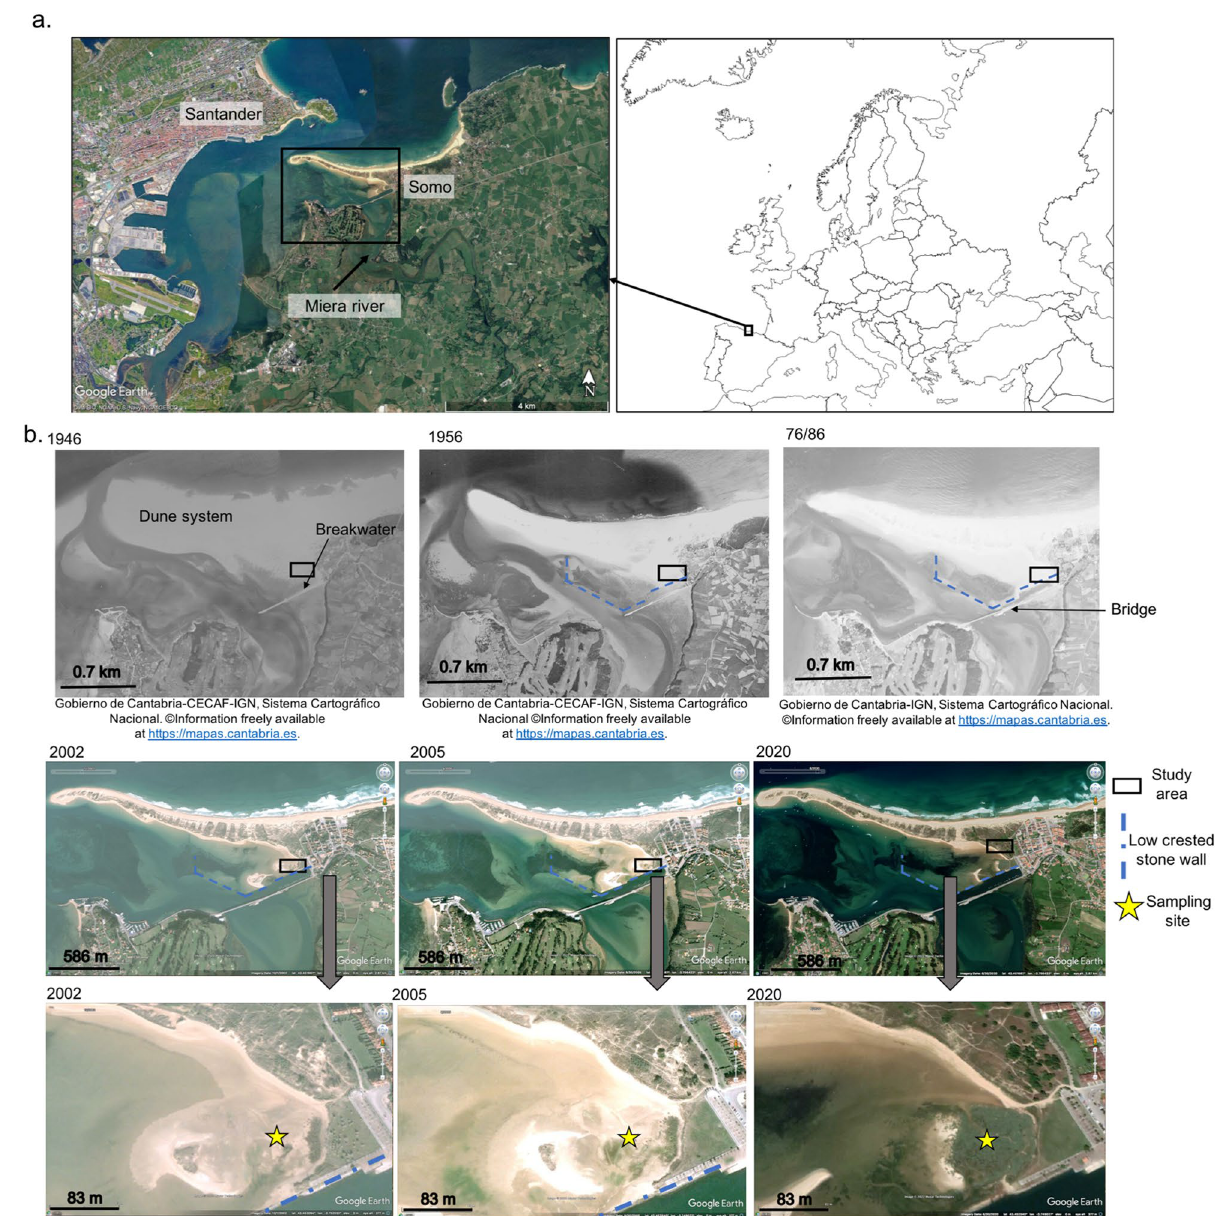
Figure 1. Study site: ( a ) Location of the study area in the Bay of Santander estuary, in the north of the Iberian Peninsula and ( b ) past sequential aerial photographs of the study area showing the location of the coastal infrastructures placed during the study period and the sampling site (43.452136°/ -3.748134°). Europe map was obtained from WIKIMEDIA COMMONS under the Creative Commons Attribution-Share Alike 3.0 Unported license. Aerial photographs were obtained from www. mapas canta bria. com (years 1946, 1956, 1976/86) and Google Earth (years 2002, 2005 and